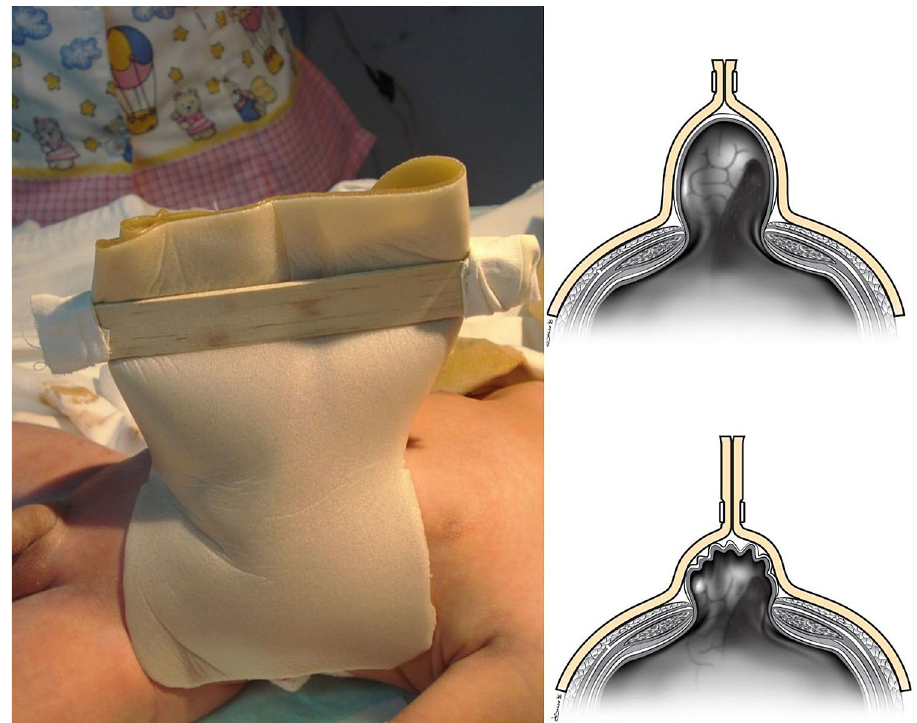
Figure 1. Phase 1 or preparing of the silo and starting the gradual reduction.